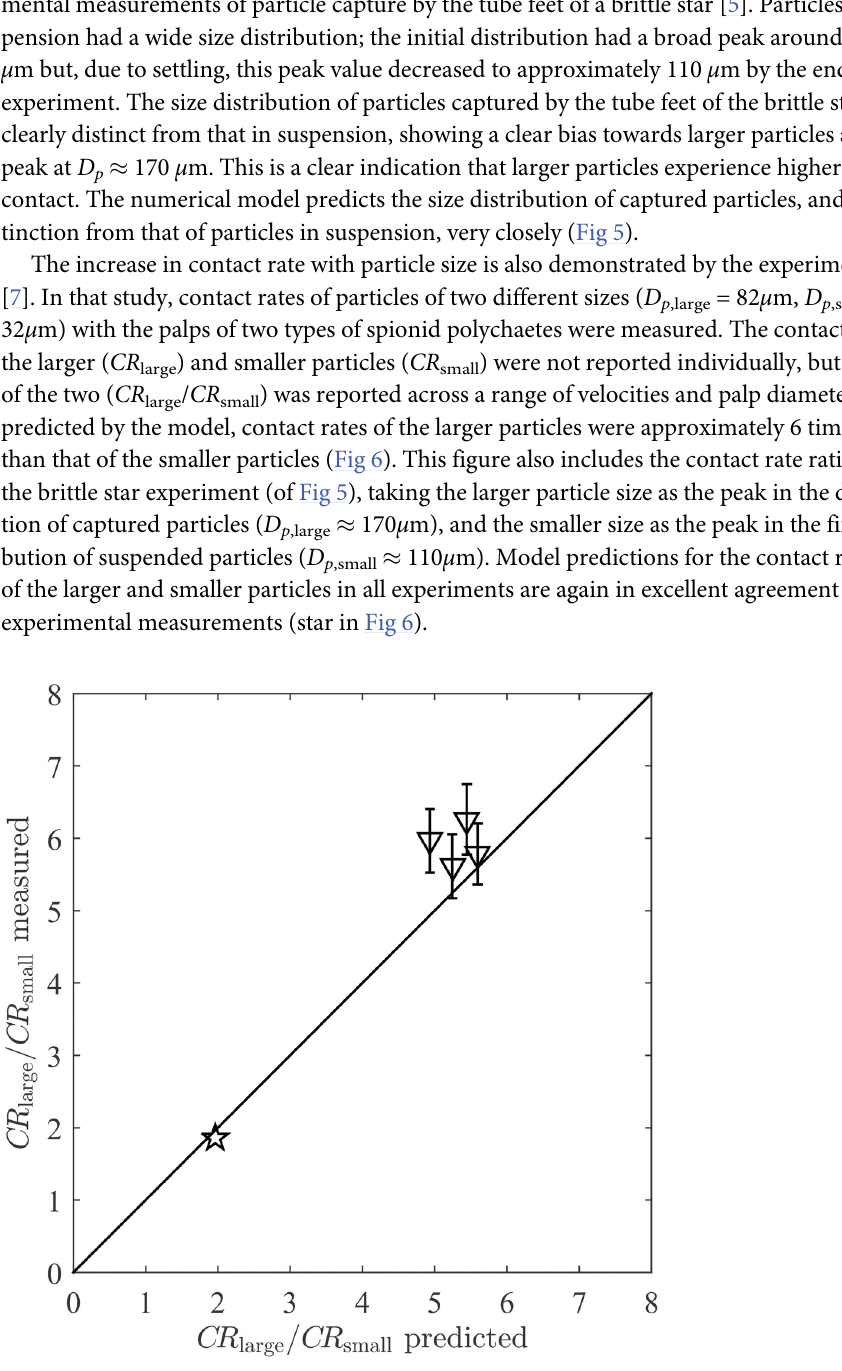
Fig 6. Comparison of model predictions with experimental measurements of the ratio of contact rates of larger and smaller particles in suspension ( CR large / CR small ). Markers represent the average of the four polychaetes � 82 μ m and D � 32 μ m (error as reported), and the brittle star experiment of experiments of [7] ( r ) with D p ,large p ,small [5] ( ☆ ) with D p ,large � 170 μ m and D p ,small � 110 μ m. The solid line represents perfect agreement.